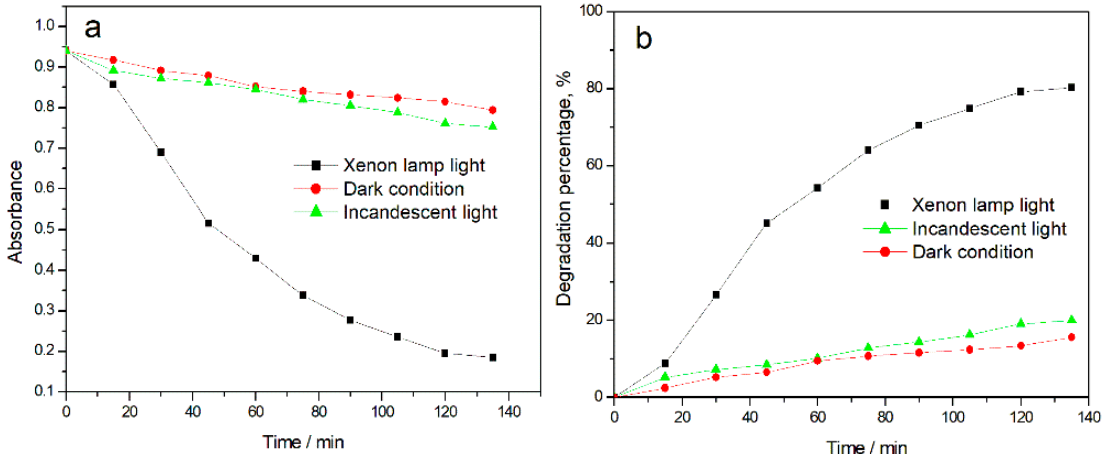
Figure 3. Absorbance curves of MB solution catalyzed by CPTPPCu/PMMA electrospun fiber under different light sources ( a ). Degradation percentage curves of MB solution catalyzed by CPTPPCu/PMMA electrospun fiber under different light sources ( b ).